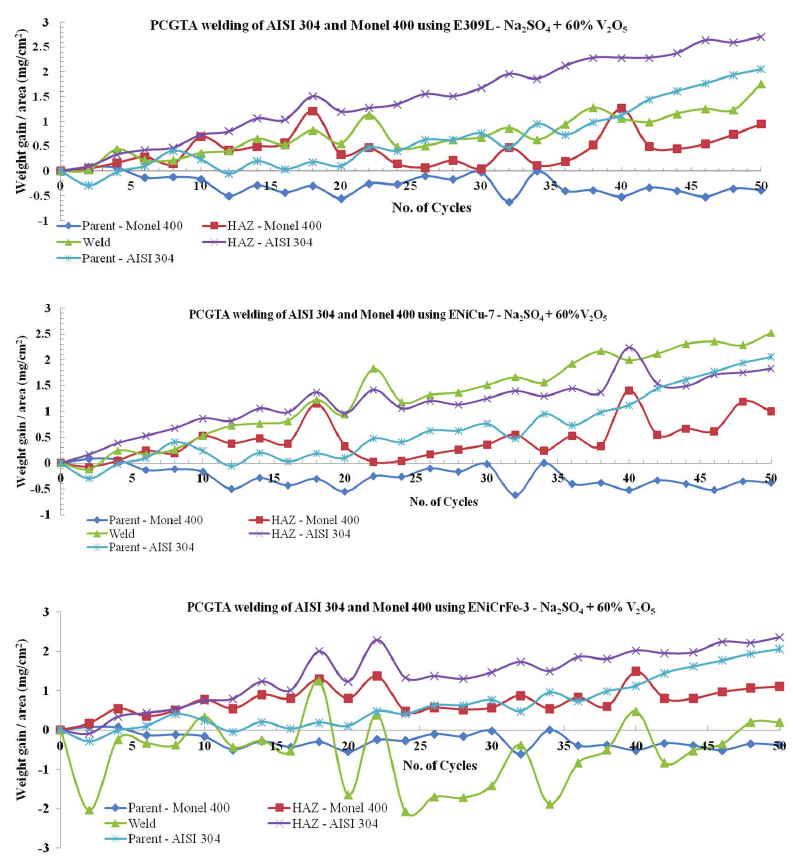
Figure 8. Thermogravimetric data of PCGTA welded dissimilar Monel 400 and AOSO 304 subjected to the molten salt environment of